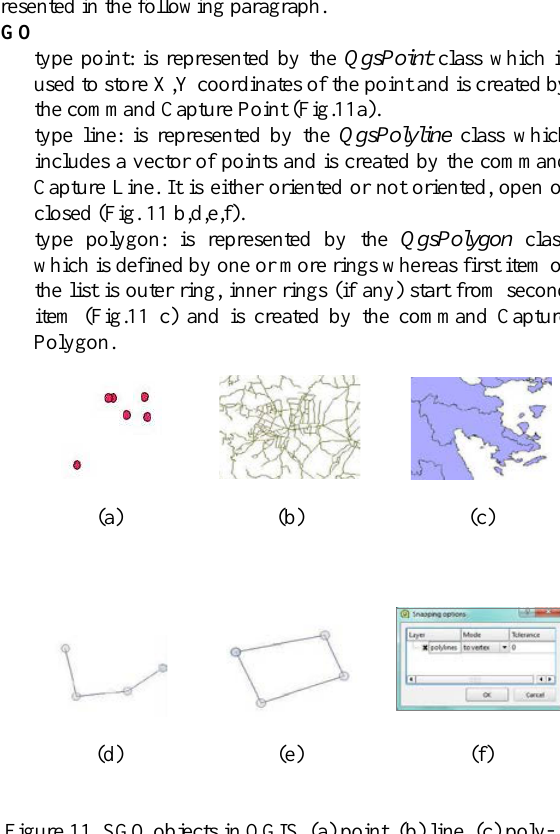
Figure 11. SGO objects in QGIS. (a) point, (b) line, (c) poly- gon, (d) open line, (e) closed line, (f) option for oriented or not